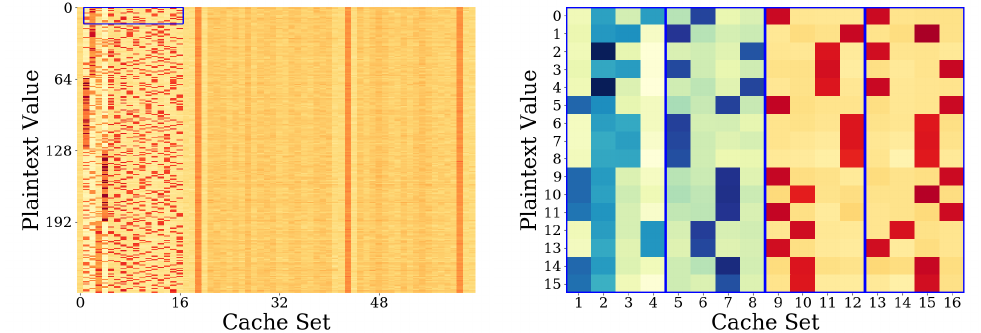
Figure 8: Second step in reversing the Shift-Rows permutation. Full information (left) and marked detail (right). The first and second S-Boxes in the right figure (marked in blue) show the same pattern up to exclusive or with